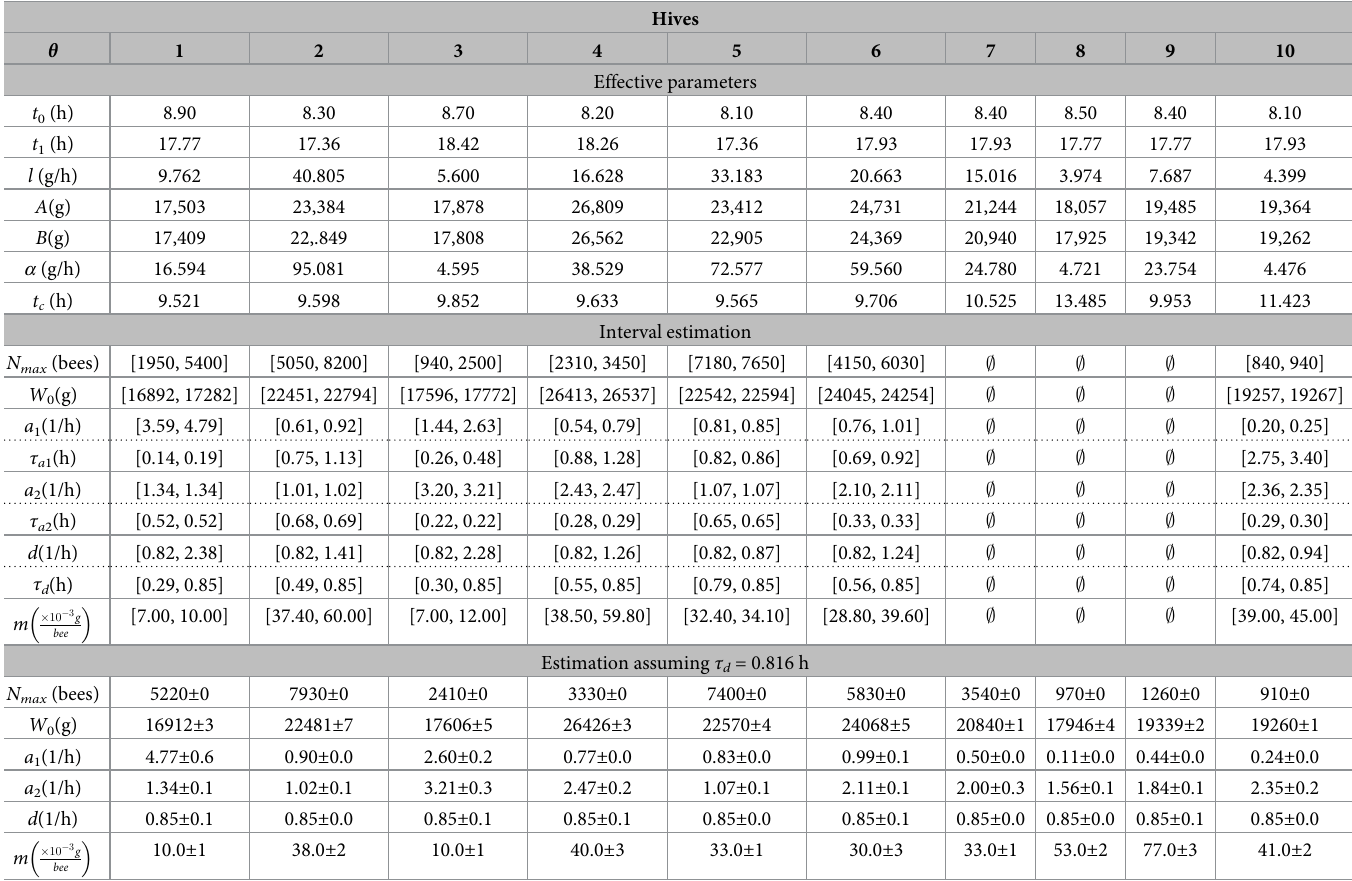
Table 2. Inferred parameters for 10 different hives on the same day (2018–4-7). Values ; in the interval estimation indicates that there was no interval of parameters sat- isfying all imposed constraints for this hive.The values of τ next to the parameters a 1 , a 2 , and d correspond to the time spent outside (respectively, inside) the hive and were computed using Eq (12). The uncertainties in the values of the estimation assuming τ d = 0.816 h minutes, reported under the curly brackets, were computed using boot- strapping, see Materials and methods Sec.